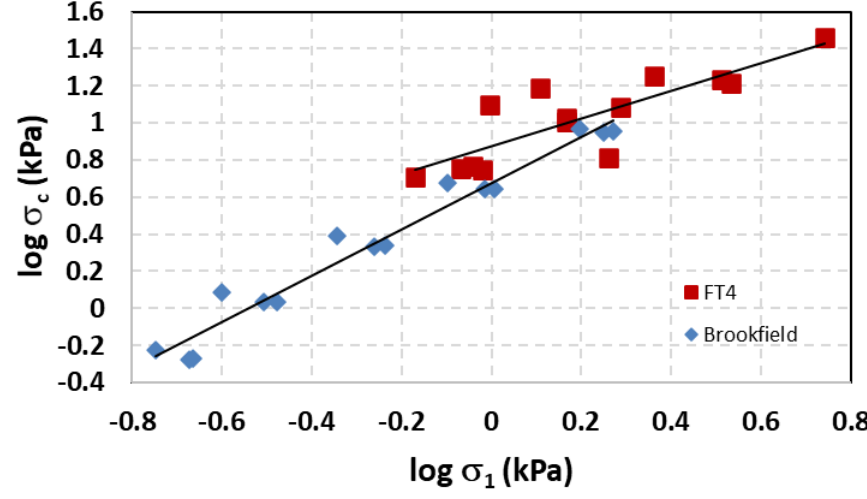
Figure 11. Flow function of maltodextrin.